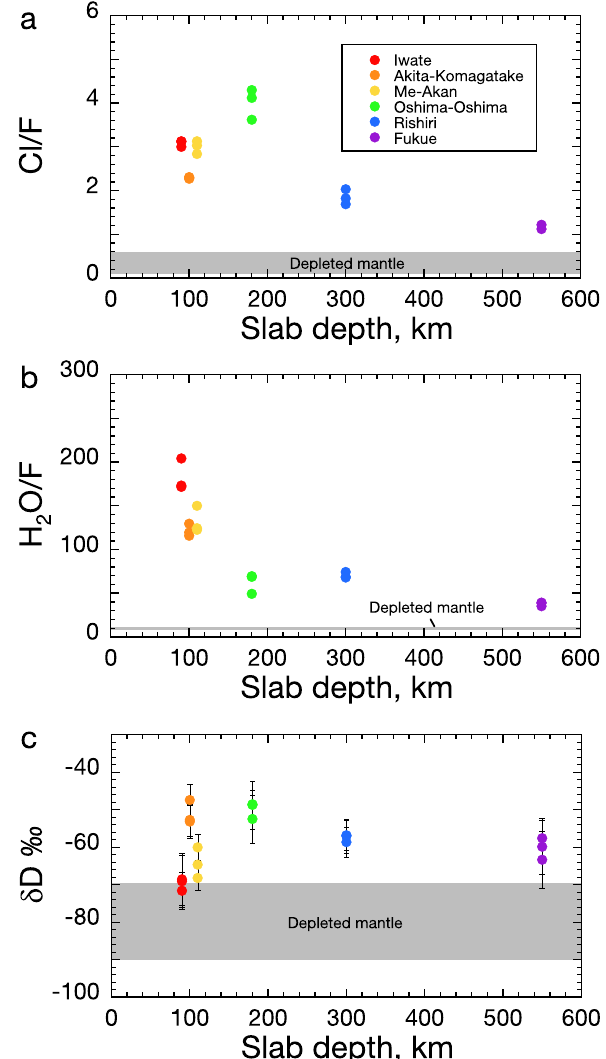
Figure 2. ( a ) Cl/F ratios, ( b ) H 2 O/F ratios, and ( c ) δD‰ values of the representative olivine-hosted melt inclusions from the Iwate, Akita-Komagatake, Me-Akan, Oshima-Oshima, Rishiri, and Fukue volcanoes, plotted as a function of the depth of the subducting Pacific Plate. The values of the depleted mantle (or the majority of MORB) for the Cl/F ratios, H 2 O/F ratios, and δD were sourced from Ref. 25 , Ref. 26 , and Ref. 7 ,